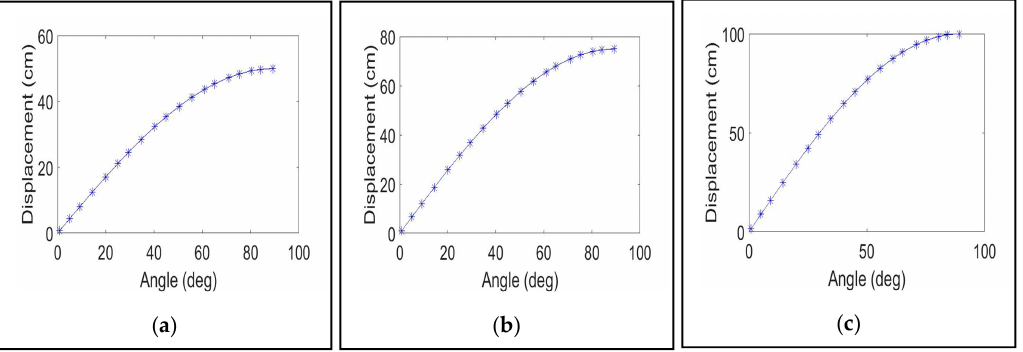
Figure 6. Relationship between the displacements and angles from the accelerometry device (a) COM = 50 cm (b) COM = 75 cm (c) COM = 100 cm.